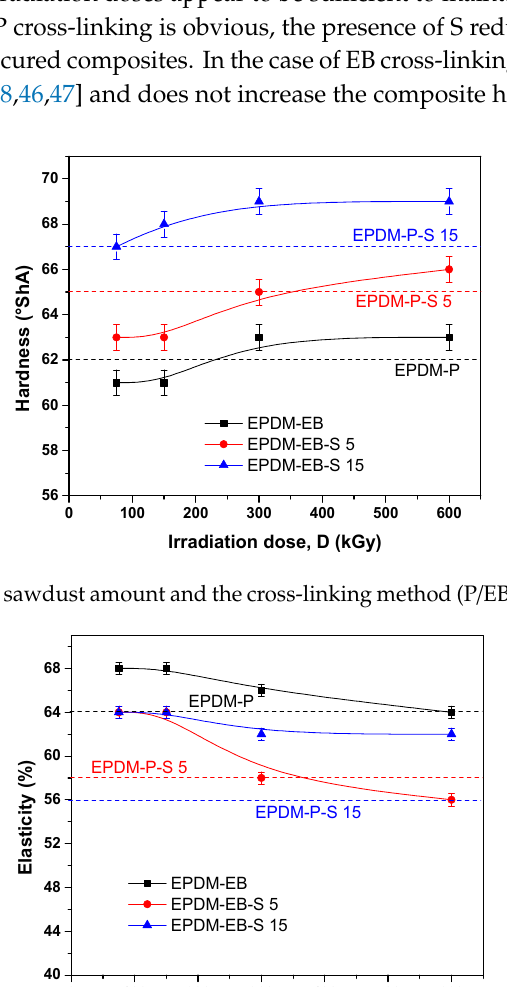
Figure 2. The influence of sawdust amount and cross-linking method (P / EB) on composites elasticity.